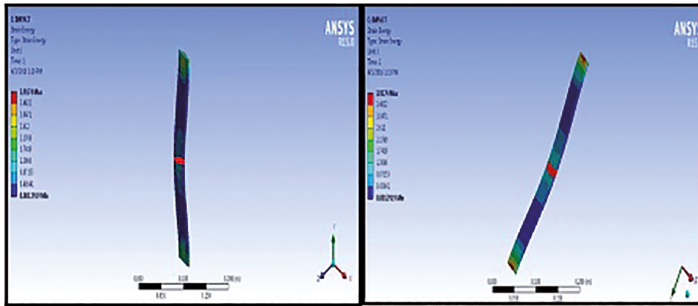
Figure 16: Impact test (a) strain energy modeling and (b) maximum strain energy